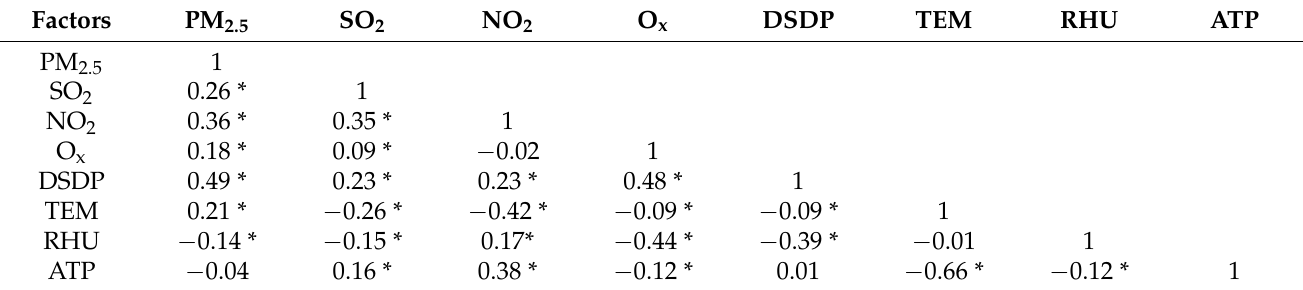
Table 2 shows the results of the spearman rank correlation between average levels of air pollutants and meteorological factors. PM 2.5 , desert sand dust particles, and SO 2 had significant relationships with NO 2 and O x . A significant correlation coefficient between NO 2 and O x was not observed. SO 2 , NO 2 , and desert sand dust particles had significantly negative correlations with temperature, while there was a significantly positive relationship between PM 2.5 and temperature. Table 2. The coefficient of spearman rank correlation between air pollutants and meteorological factors in Matsue City, Japan. Factors PM 2.5